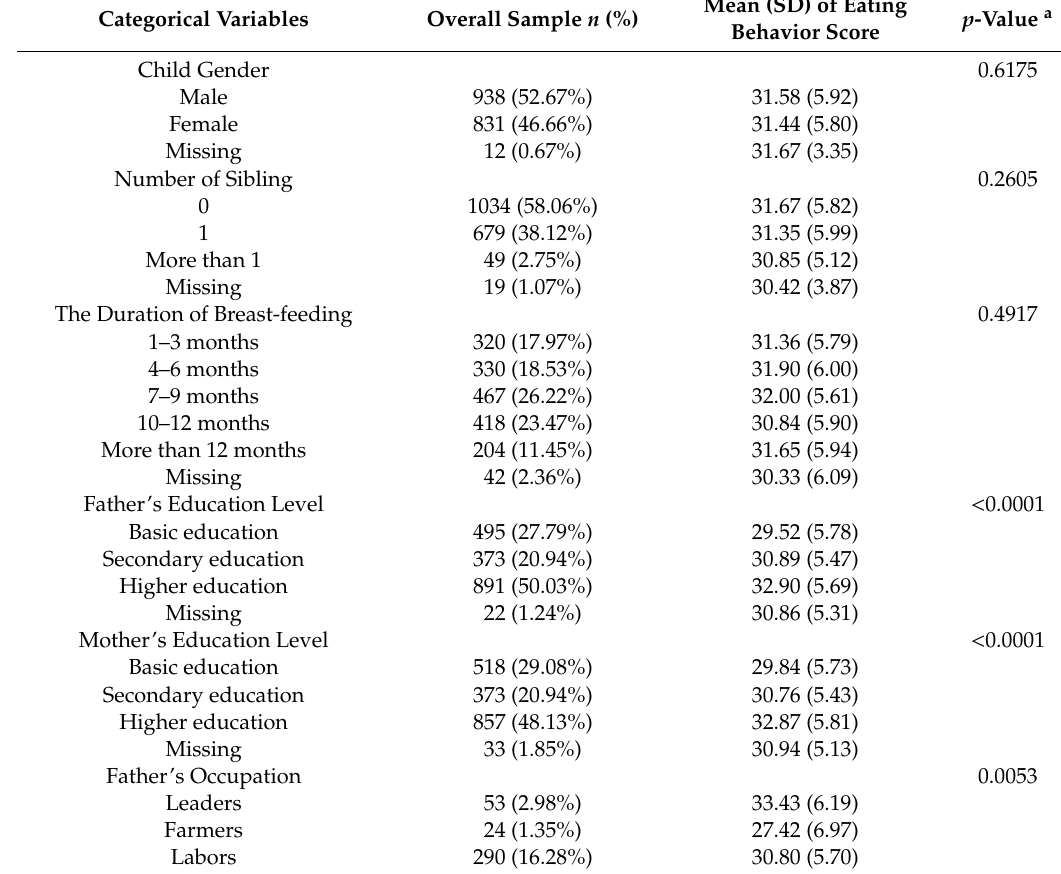
Table 1. Characteristics of the study